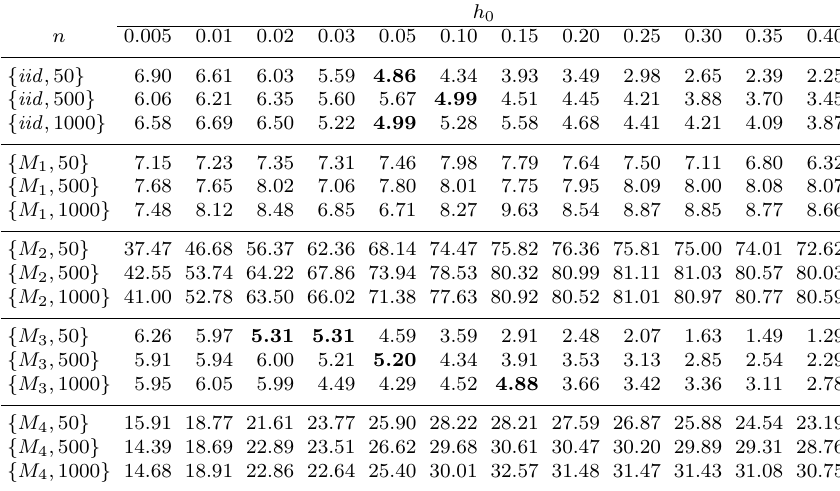
Table 1. T n percentage rejections of the true H 0 at 5% significance level with n = 20 , 50 , 100 for the iid case and models M 1 and M 3 made with 10,000 replications, h = h 0 n − 1 / 4 ; kernel U [ − 1 ,